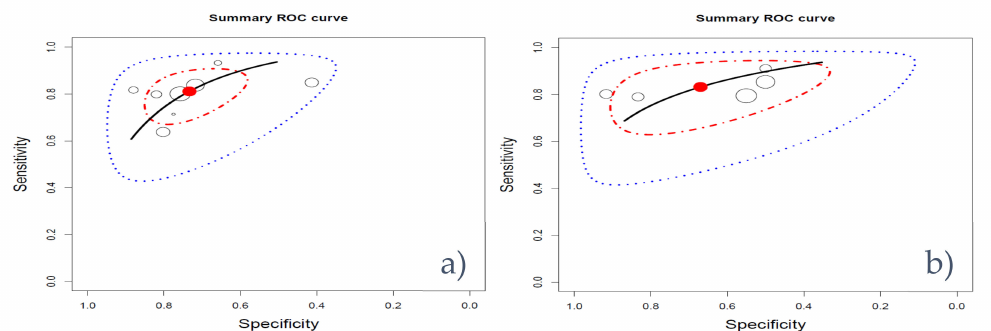
Figure 5. Hierarchical receiver operating characteristic curves for biopsies ( a ) and prostatectomies ( b ). Studies are represented by circles with a size proportional to their data size, red = optimal working point, black line = curve, red line = 95% confidence region, blue line = 95% predicted